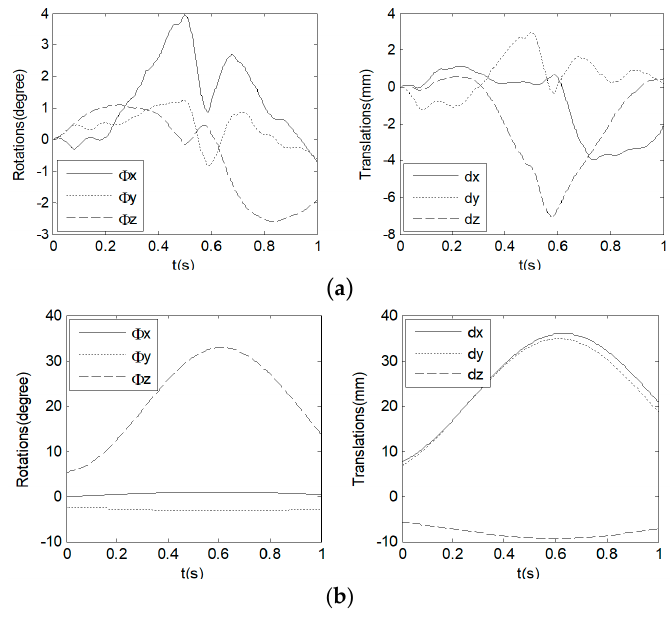
Figure 3. The phantom motion: ( a ) Slight motion; ( b ) large motion.